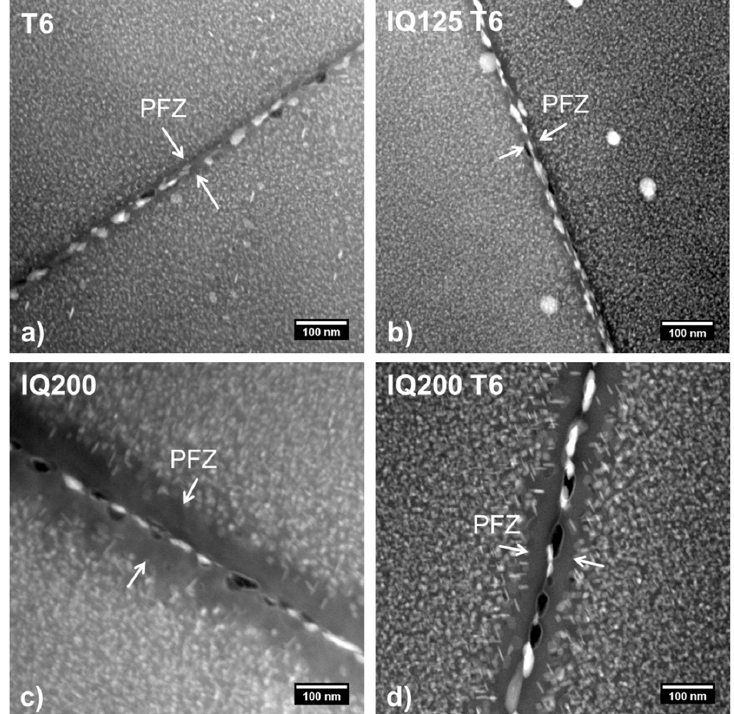
Figure 4. ( a – d ): STEM HAADF images of edge-on grain boundaries indication the precipitation-free zones (PFZs) in the alloy AA7050 in a conventional T6 state ( a ) and after IQ125 T6 ( b ), IQ200 ( c ) and IQ200 T6 ( d ).